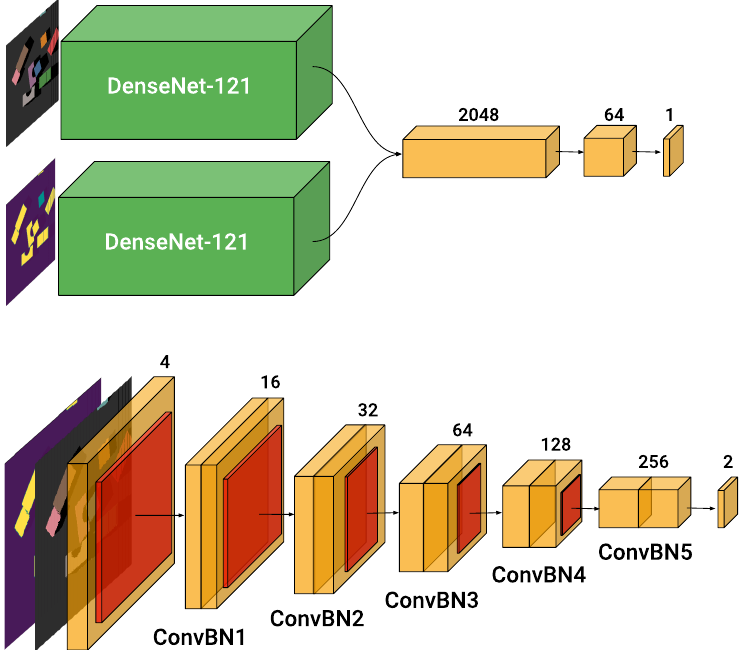
Figure 6. At the top: VPG architecture from the original work. Each ConvBN block represents a concatenation of a convolutional layer, followed by a batch normalization layer and a linear rectifier (ReLU). The input of the first DenseNet-121 architecture is RGB data, the second DenseNet-121 network receives as an input a cloned version of the depth data (DDD). The output consists of a single channel of 20 × 20 px that corresponds either to the push or the grasp Q-value map. The full system consists of two instances of the presented architecture, one for grasp primitives and the other for push primitives. At the bottom: Single-FCN architecture. Each ConvBN block represents a concatenation of a convolutional layer, followed by a batch normalization layer and a linear rectifier (ReLU). The input of the network is RGBD data, with a resolution of 640 × 640 px. The output consists of two channels of 20 × 20 px, which correspond to the push and grasp Q-value